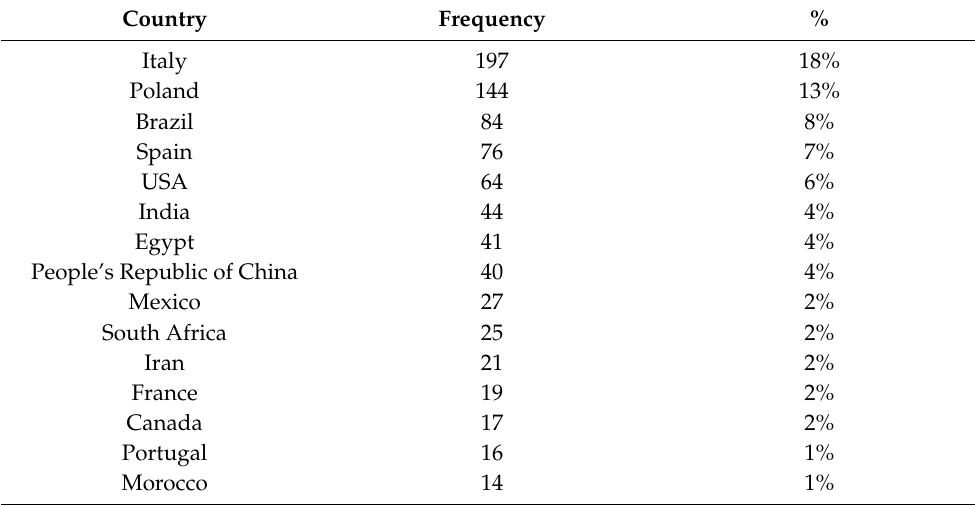
Table 4. Top 15 most productive countries in biostimulant